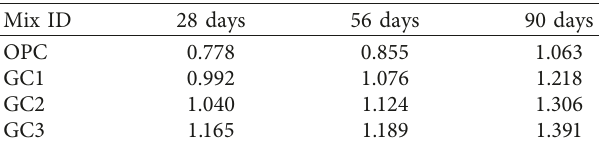
Figure 10: Variation of (a) percentage weight loss and (b) compressive strength after sulphate test as a function of curing period. Table 6: Weight loss in percentage of the geopolymer and OPC concrete mix after sulphate test for different curing periods.